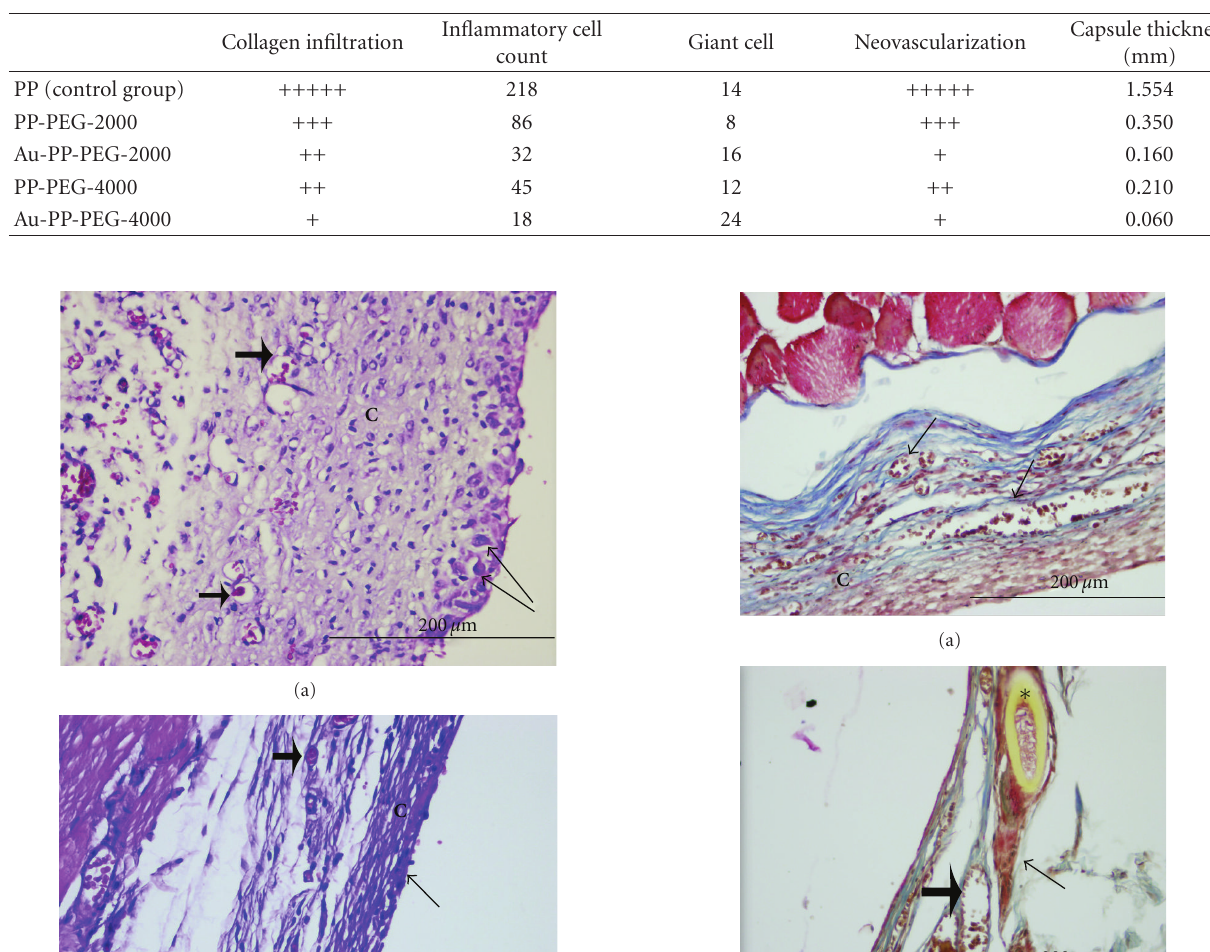
Table 1: Histological findings of polymer blocks following 30 days of implantation.